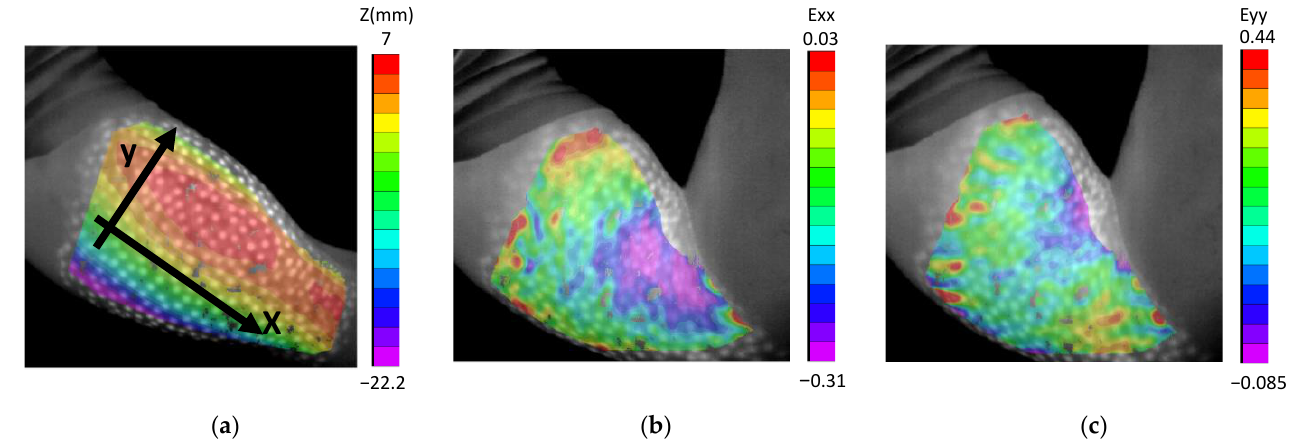
Figure 9. Results from strain analysis on arm flexion. ( a ) Image of digitalization of the arm with the reference coordinates system. ( b ) Strain along humerus direction (x) during flexion. ( c ) Strain along transversal direction to humerus (y) during flexion .